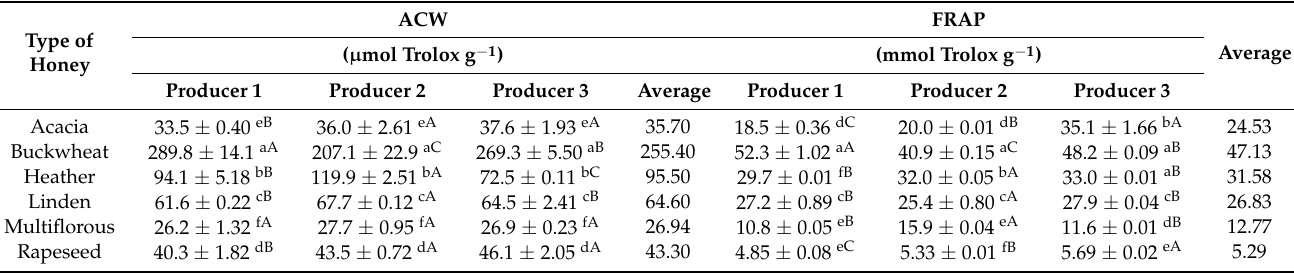
Table 3. Data on antioxidant activity measured with ACW and FRAP assays.